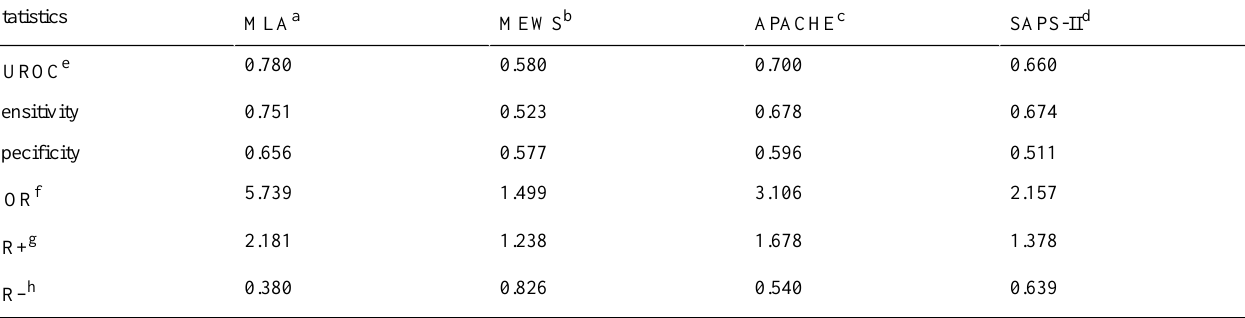
Table 2. Performance metrics for the machine learning algorithm and all comparator scores for mortality prediction on the total study population.